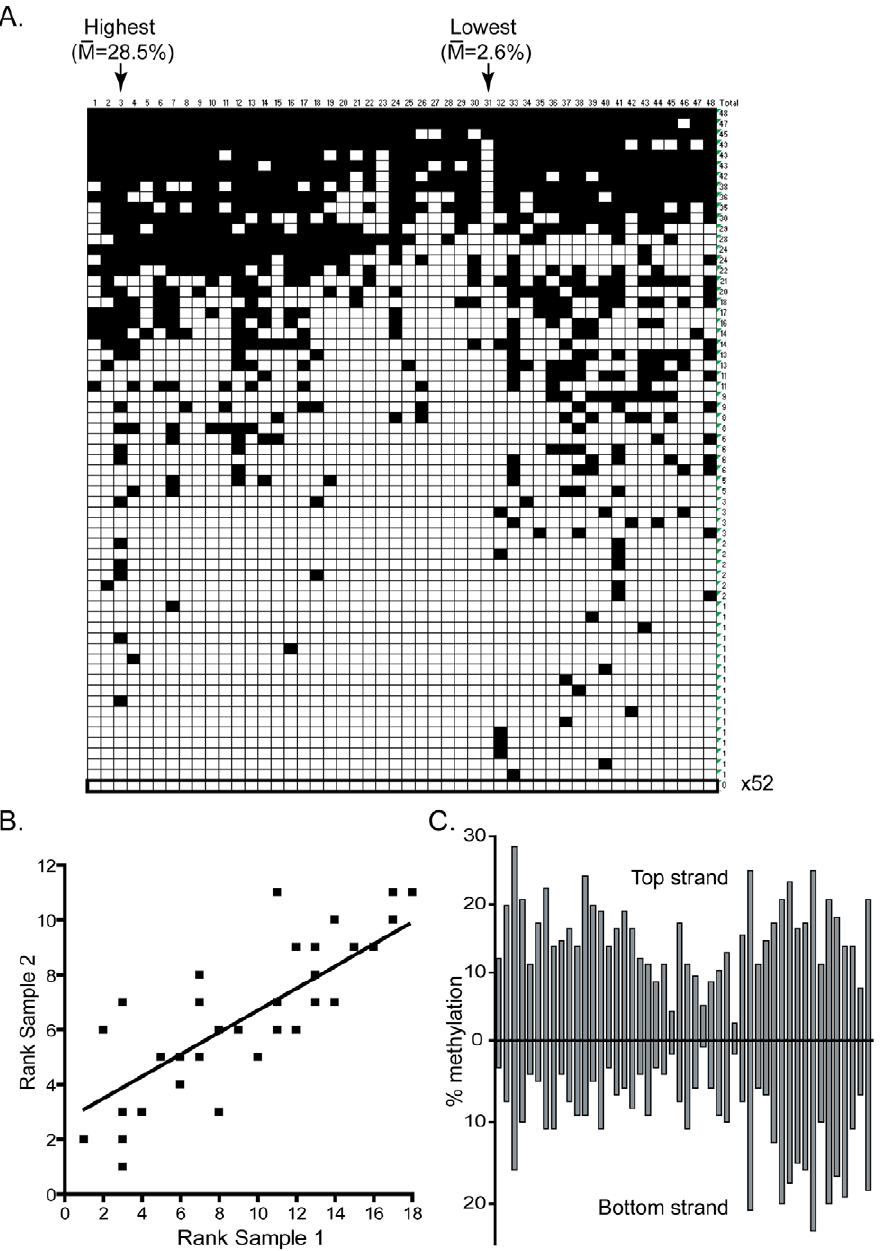
Figure 1. DNMT3A methylation patterns are characterized by reproducible and symmetrical high and low efficiency methylation sites. A. This panel represents the DNA methylation patterns deposited by DNMT3A at the pBR top strand region as determined by bisulfite methylation sequencing. Each horizontal line corresponds to an independent DNA molecule while each vertical line corresponds to one of the 48 CpG sites in this region. Black squares indicate CpG methylation while white squares represent absence of methylation. The arrows indicate the two sites with the greatest and least methylation frequencies, respectively, along with their corresponding methylation frequencies. B. Two independent in vivo samples were analyzed for their DNA methylation patterns and the CpG sites were ranked according to their methylation efficiency. The ranks observed at each of the 48 CpG sites were then plotted against each other in one sample versus another. Overall, a good correlation exists between methylation ranks, indicating that the methylation patterns for DNMT3A are reproducible. C. The individual methylation efficiency at each CpG site along the pBR322 region are plotted for both top and bottom DNA strands. The patterns observed are clearly symmetrical across DNA strands.